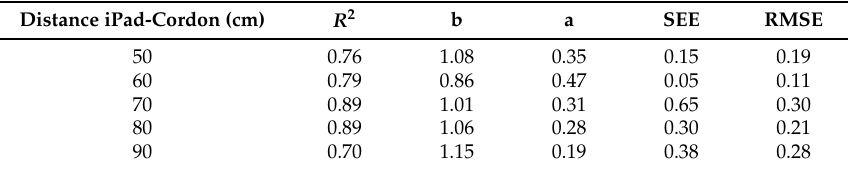
Table 3. Statistics of the correlation between the results obtained with the planimetric and gravimetric method and VitiCanopy as a function of the distance between the iPad4 and the vine’s cordon. R 2 = coefficient of determination, b = Slope, a = Intercept, SEE = standard error of estimates, RMSE = root mean squared